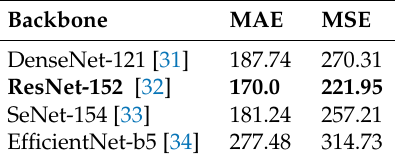
Proposed MH-MetroNet architecture performance with different backbones on UCF_CC_50 datasets. Backbone MAE MSE DenseNet-121 [31] 187.74 270.31 ResNet-152 [32] 170.0 221.95 SeNet-154 [33] 181.24 257.21 EfficientNet-b5 [34] 277.48